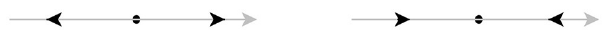
FIGURE 1 | The local flow around a simple equilibrium for λ > 0 (unstable, left) and for λ < 0 (stable, right), where λ is given by Equation (8).